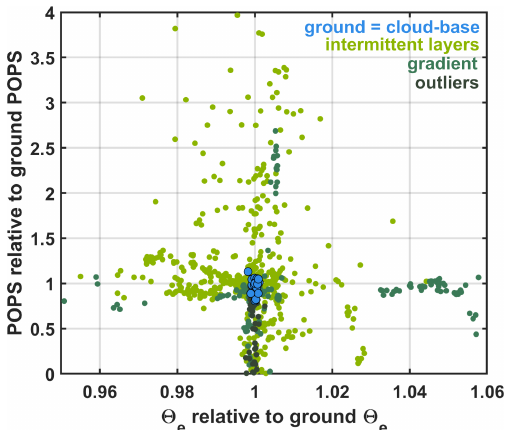
Figure 8. Scatterplot of POPS aerosol number concentrations and θ E relative to their ground values (20–40m) for each profile. Data are from the 63 profiles containing POPS and θ E throughout the entire below-cloud environment. Each point represents data from one altitude; thus, there are several data points per profile. Data are grouped by case, including profiles where ground aerosol was equivalent to concentrations at cloud base under well-mixed condi- tions (9 profiles), profiles with intermittent layers of aerosol under stratified conditions (37 profiles), profiles with gradients in aerosol under stratified conditions (9 profiles), and outliers where the atmo- spheric stability and mixing cannot be used to explain the vertical distribution of the aerosol (7